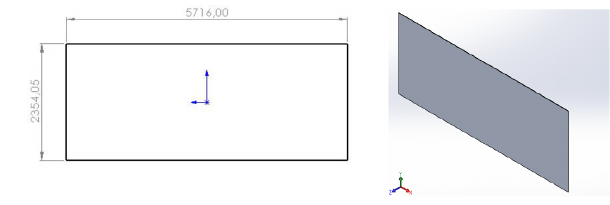
Figure 7: Geometrical model of the flat